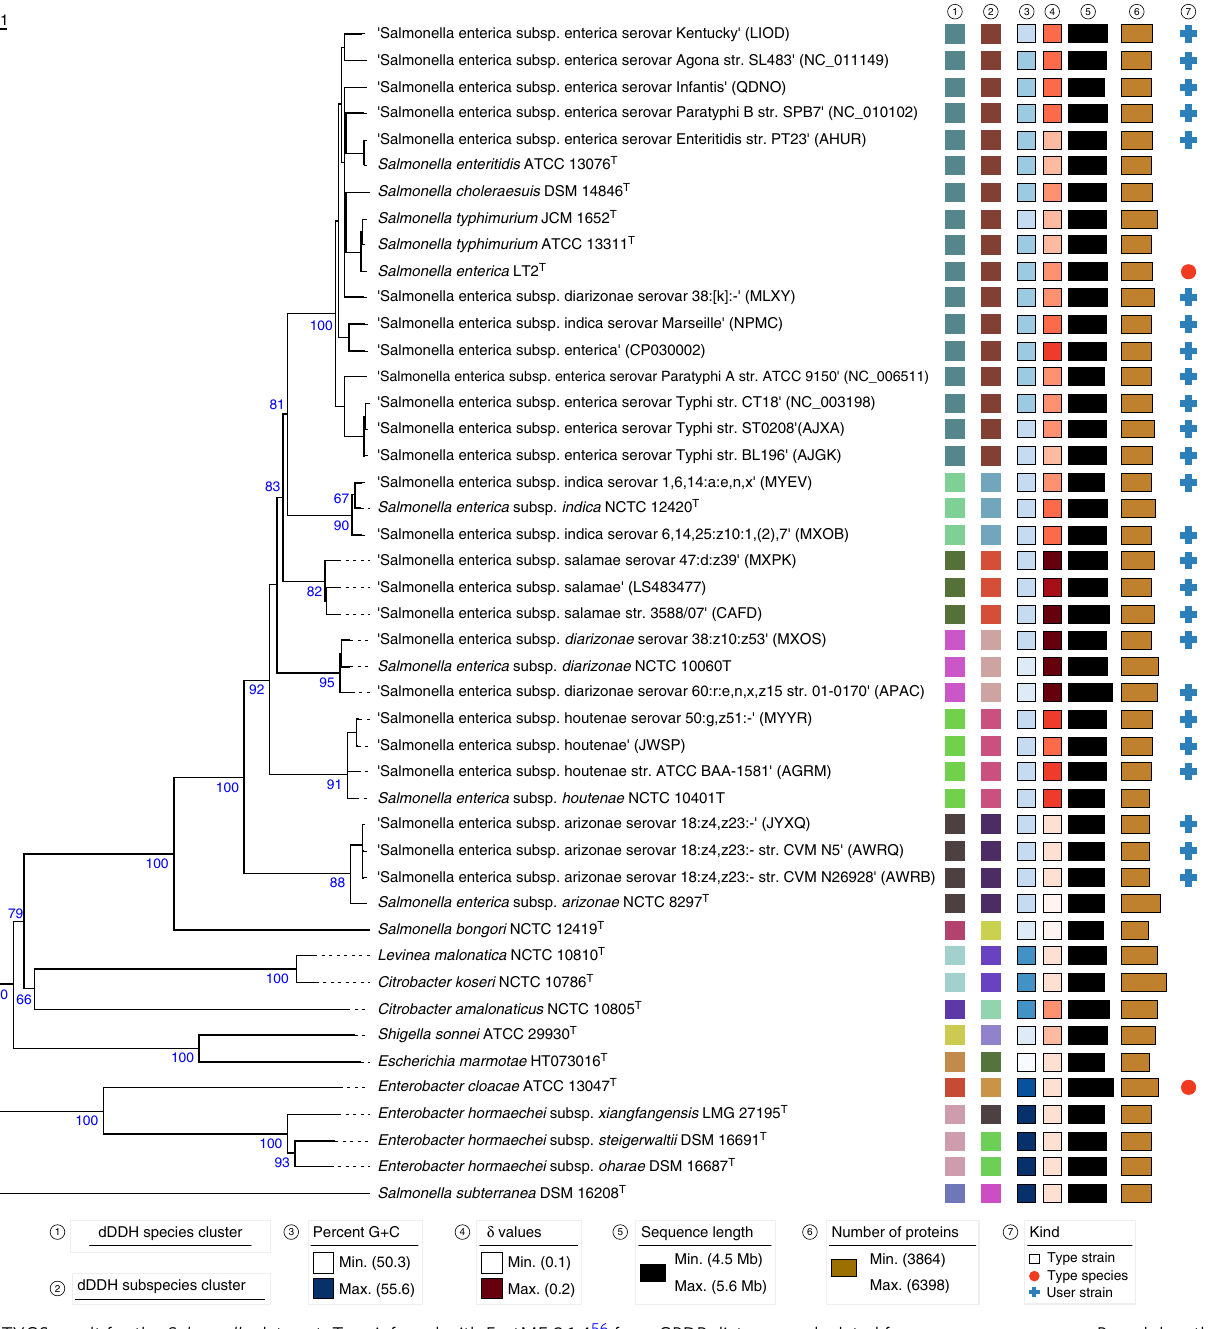
Fig. 3 TYGS result for the Salmonella data set. Tree inferred with FastME 2.1.4 56 from GBDP distances calculated from genome sequences. Branch lengths are scaled in terms of GBDP distance formula d 5 ; numbers above branches are GBDP pseudo-bootstrap support values from 100 replications. Leaf labels are annotated by af fi liation to species (1) and subspecies (2) clusters, genomic G + C content (3), δ values (4), overall genome sequence length (5), number of proteins (6), and the kind of strain (7). User-provided GenBank accession IDs are shown in parentheses; master record accessions are